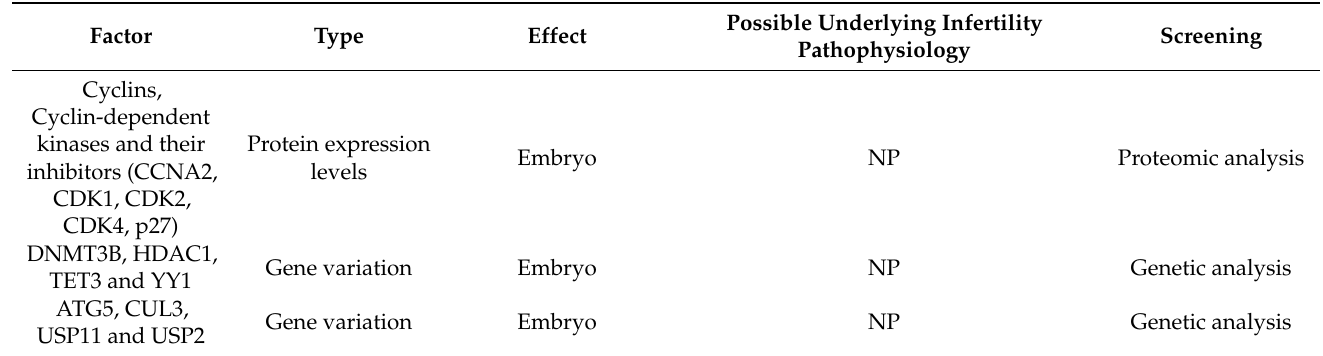
Table 2. Factors affecting developmental